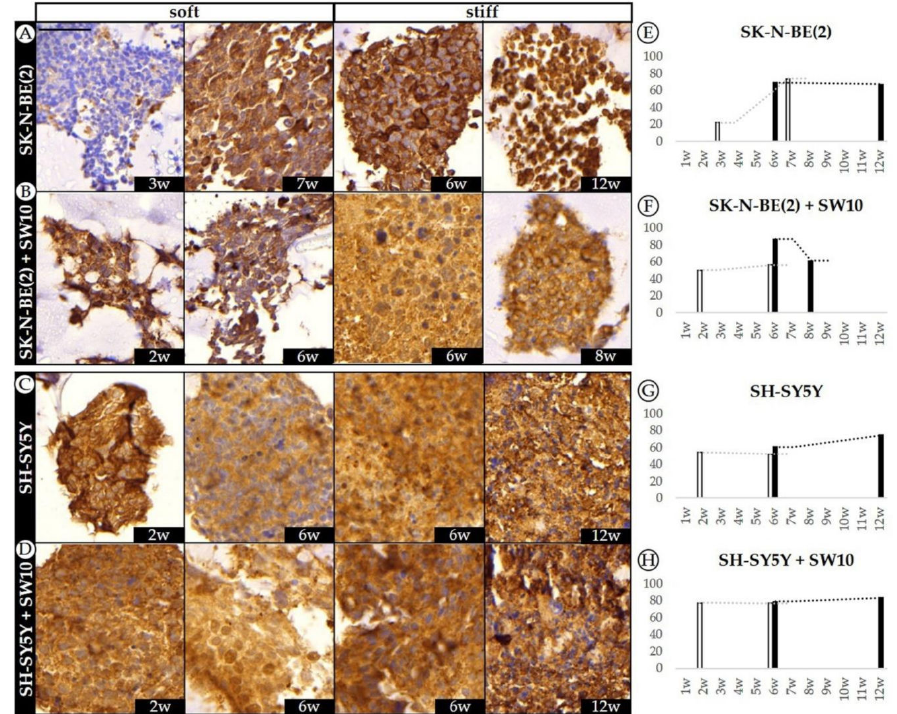
Figure 6. Dynamics of KANK1 expression pattern in SK-N-BE(2) and SH-SY5Y over time. ( A – D ) Representative images of KANK1 expression at the time points studied (w: weeks) in soft and sti ff sca ff oldings. The top images correspond to the SK-N-BE(2) cell line cultivated ( A ) alone and ( B ) with SW10; the images at the bottom represent the SH-SY5Y cell line cultivated ( C ) alone and ( D ) with SW10 cells. Scale bar 50 µ m at top left of the first image. Same scale bar is valid for all images. ( E – H ) Bar chart quantification of KANK1 staining (% of positive cells) for SK-N-BE(2) cells ( E ) alone and ( F ) SK-N-BE(2) cells plus SW10 cells in soft and sti ff sca ff olds, and SH-SY5Y cells ( G ) alone and ( H ) S-SY5Y cells plus SW10 cells in soft and sti ff sca ff olds. White and black bars: soft and sti ff sca ff olds, respectively. Dashed lines indicate moving average per sti ff ness condition. X axis: time in weeks (w) and Y axis: % of KANK1 positive